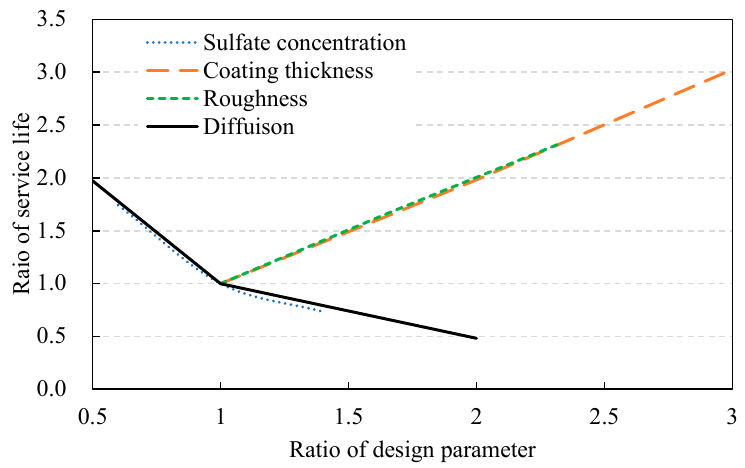
Figure 11. Relationship between design parameters and service life.